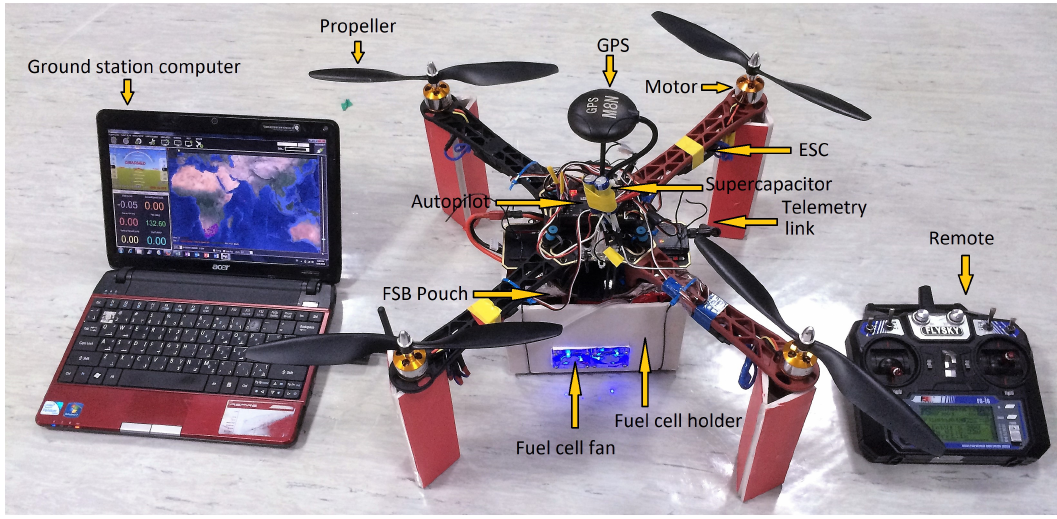
Figure 1. Overall system